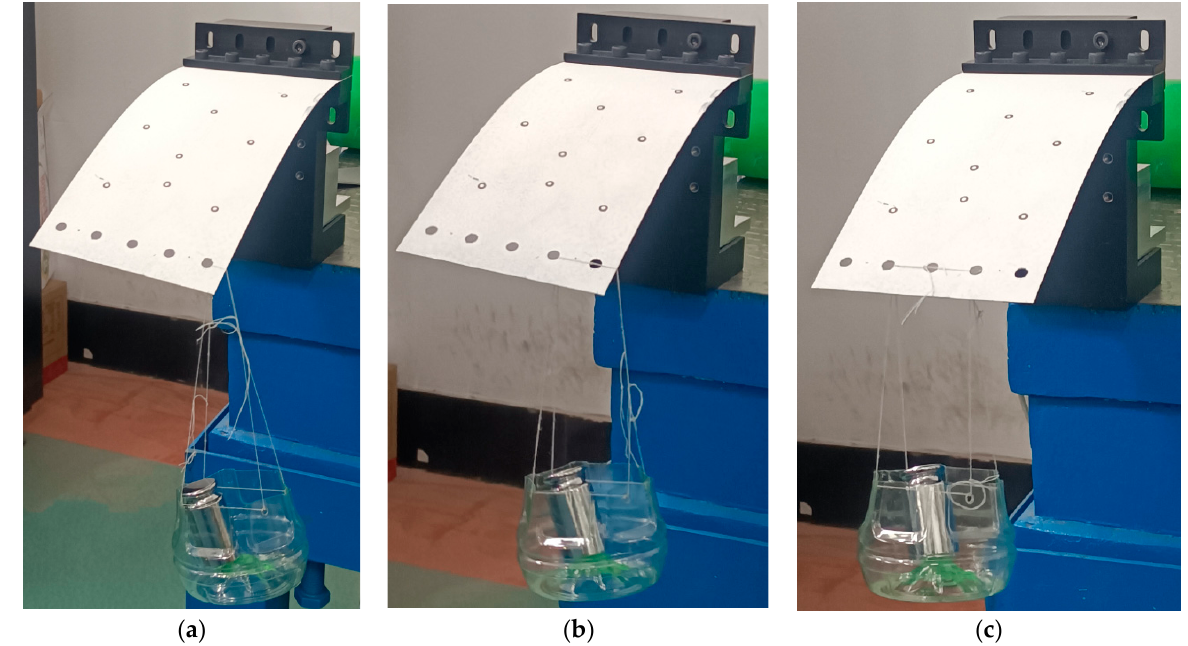
Figure 17. Deformation of the FLS under the different loading cases. ( a ) Case 1; ( b ) Case 2; ( c ) Case 3.